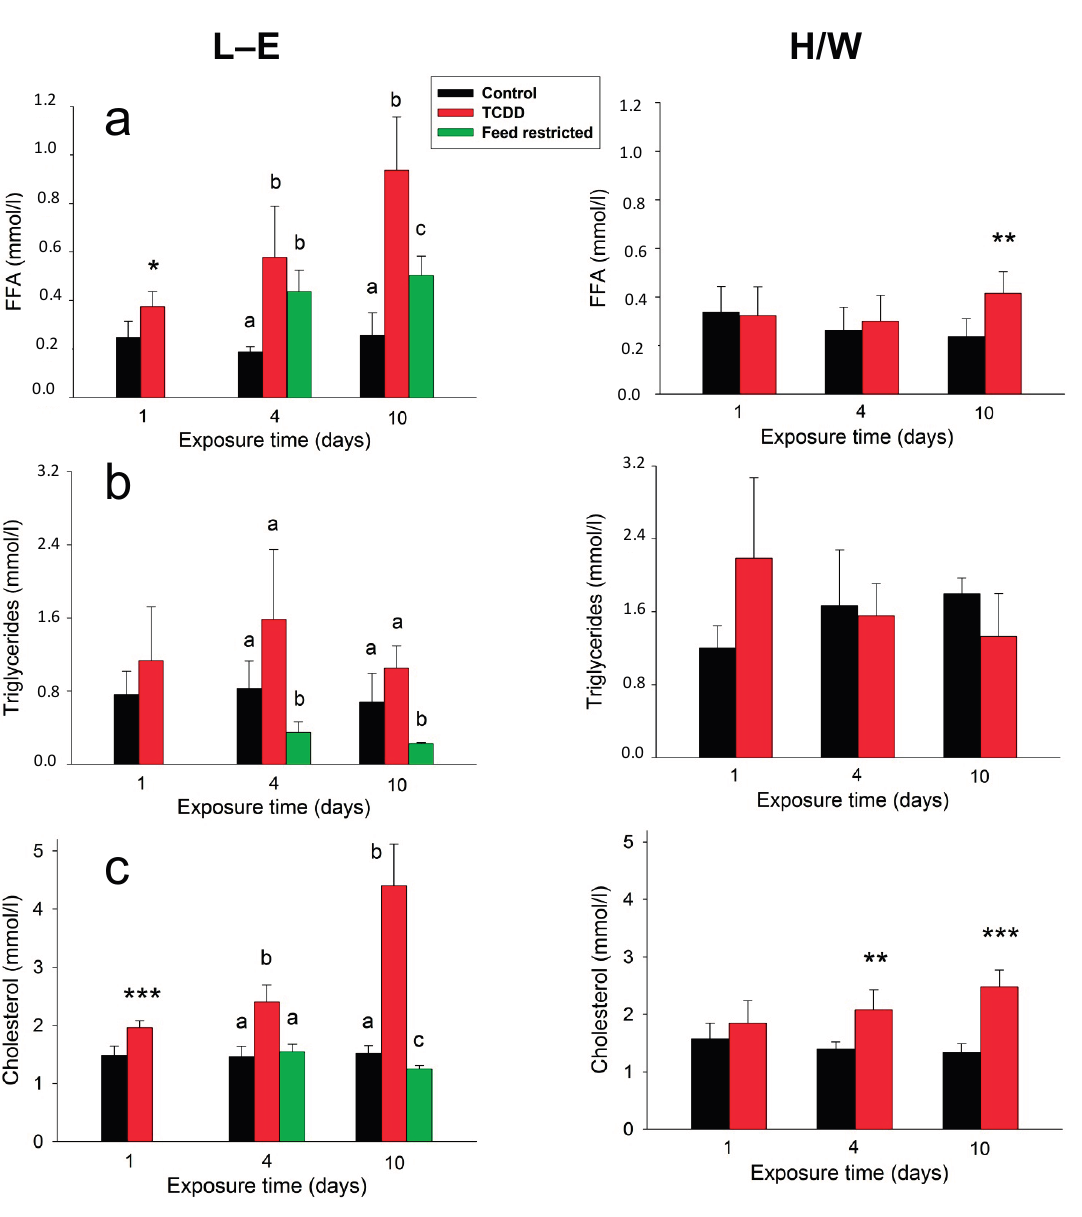
Figure 6. The effect of TCDD or feed restriction on ( a ) serum FFA; ( b ) triglyceride and ( c ) cholesterol concentrations in L-E ( left panel) and H/W rats ( right panel) as a function of time (mean ± SD). The conditions are as in Figure